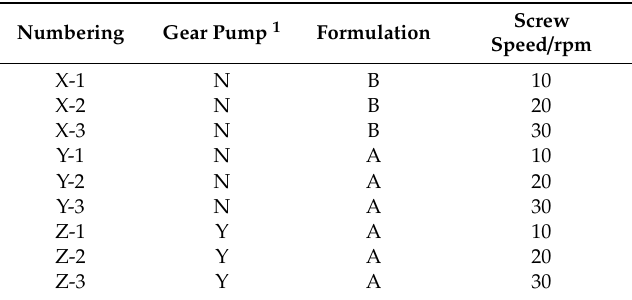
Table 3. Extrusion experimental design.